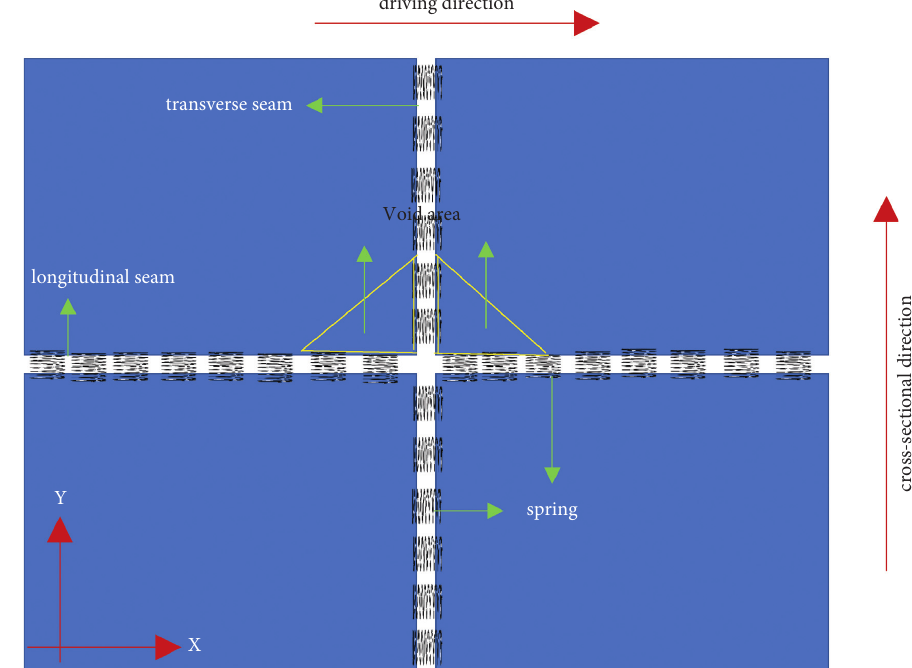
Figure 14: Cement concrete slab spring